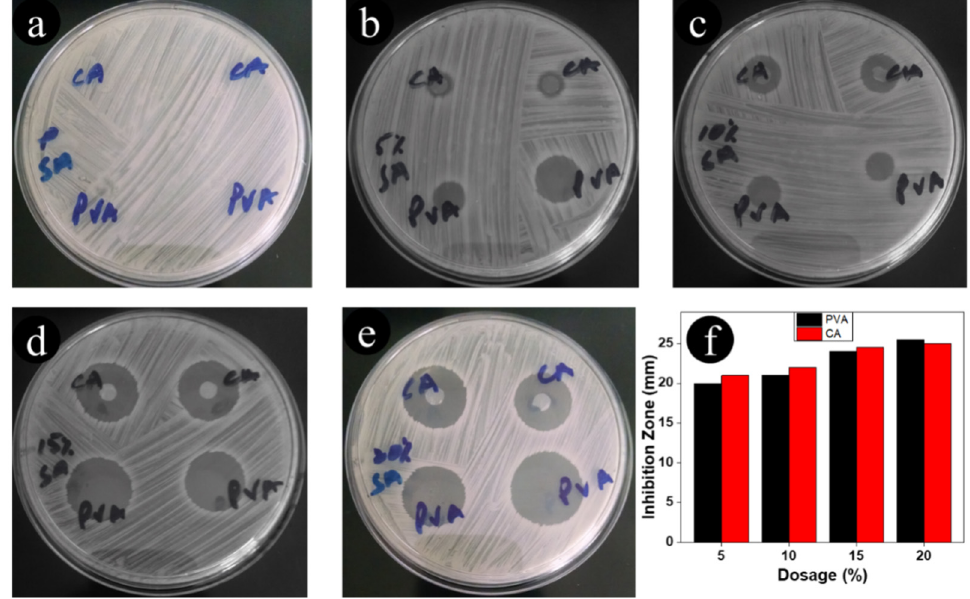
Figure 5. Antimicrobial assessment of CA and PVA nanofibers incorporated with different amounts of ceftriaxone, ( a ) 0, ( b ) 5%, ( c ) 10%, ( d ) 15%, and ( e ) 20% against E. coli ; ( f ) is a bar graph of the inhibition zones.